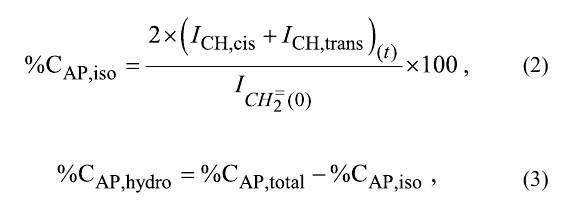
in which I CH2=(0) is the integral of the C H 2 = resonance in the 1 H-NMR spectrum of the initial mixture and I CH2=( t ) , I CH,cis( t ) and I CH,trans( t ) are the integrals of the C H 2 =, cis -C H =, and trans -C H = resonances at time t ,